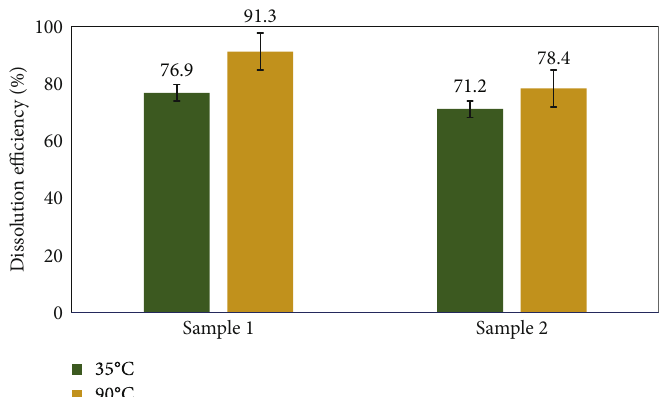
Figure 5: Dissolution e ffi ciency for the developed dissolver at di ff erent temperatures (35 ° C and 90 ° C for 24 hours).